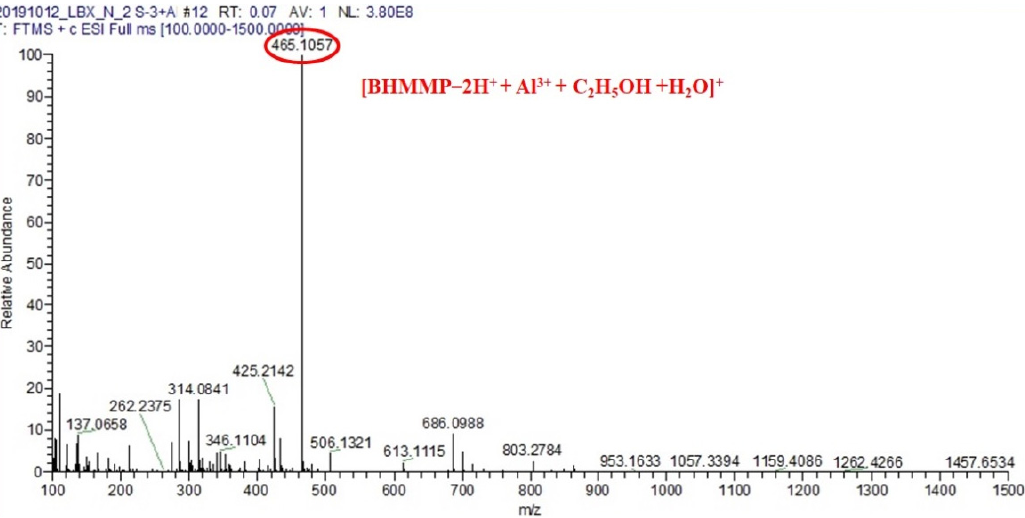
Figure 5. The ESI–MS spectrum of BHMMP –Al 3+ complex in positive ion source mode.